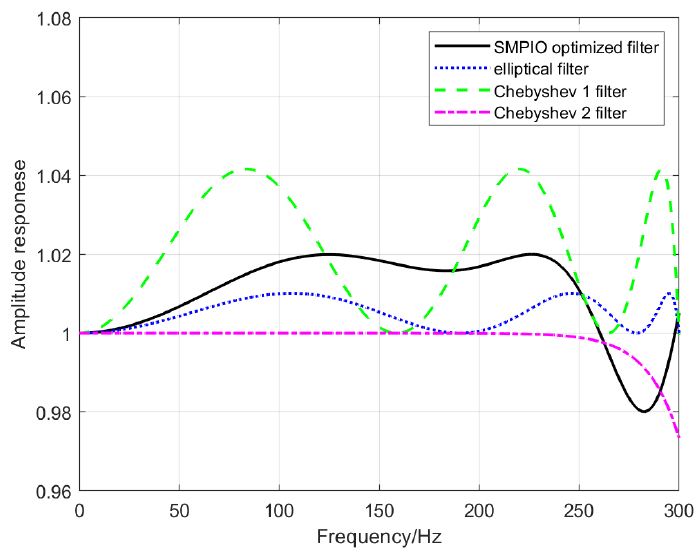
Figure 10. Amplitude response comparison of various types of filters (0 Hz~300 Hz, m = 6, amplitude and phase optimized).